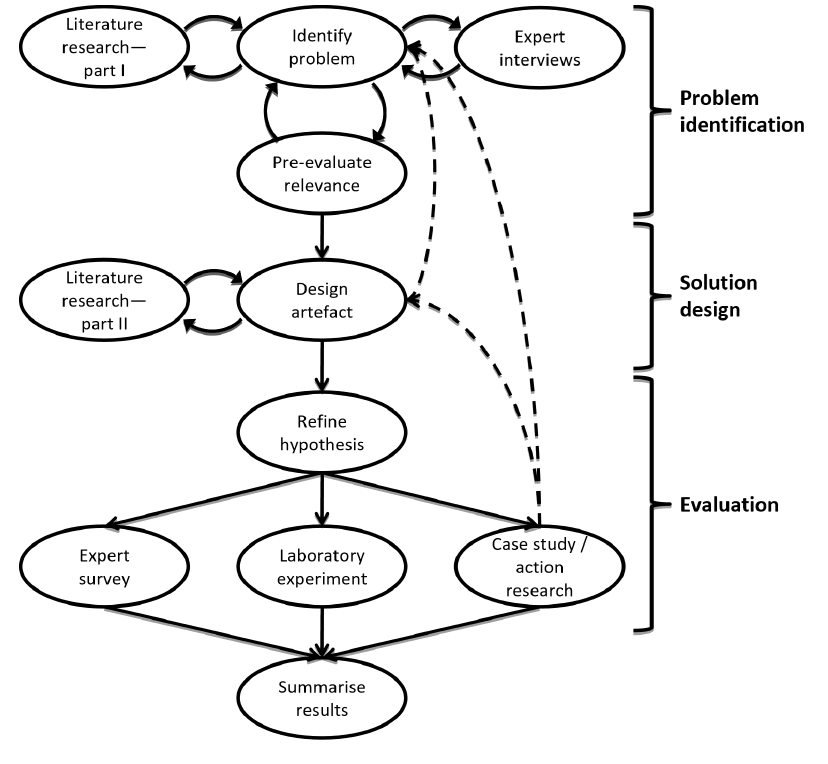
Figure 2. Design Science Research Process from